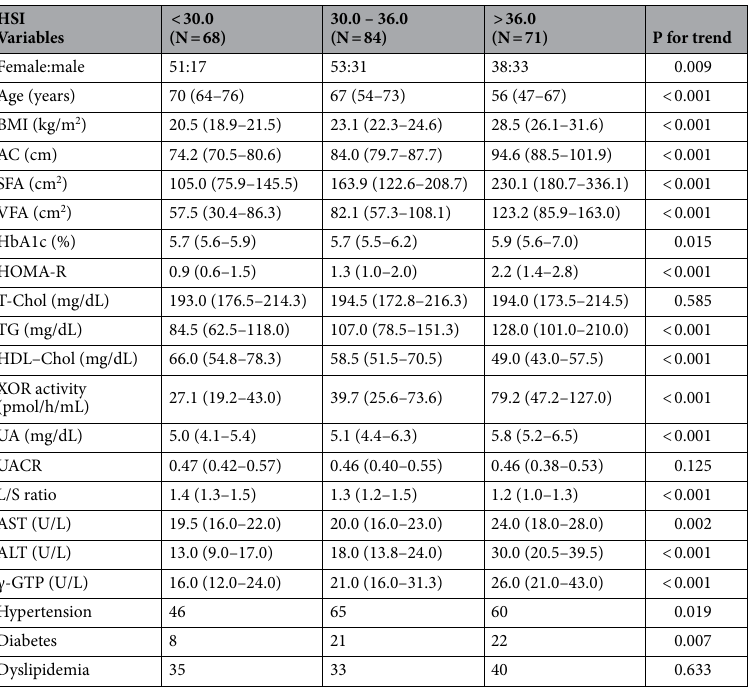
Table 3. Differences in clinical parameters based on hepatic steatosis index (HSI). Clinical parameters and the proportion of comorbidities among the three groups were examined using Jonckheere–Terpstra test or Cochran–Armitage test. BMI, body mass index; AC, abdominal circumference; SFA, subcutaneous fat area; visceral fat area, VFA; HbA1c, hemoglobin A1c; HOMA-R, homeostasis model assessment ratio; T-Chol, total- cholesterol; TG, triglycerides; HDL-Chol, high-density lipoprotein-cholesterol; XOR, xanthine oxidoreductase; UACR, urine uric acid to creatinine ratio; L/S, liver-to-spleen; AST, aspartate transaminase; ALT, alanine